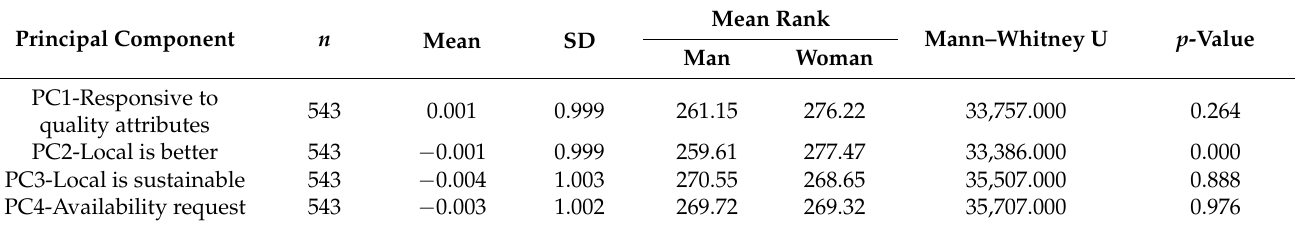
Table 3. Effects of gender on the principal components’